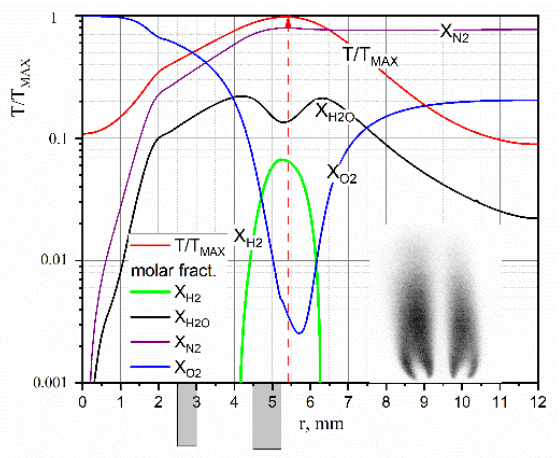
Figure 4. Reconstructed temperature and composition values in H 2 /O 2 flame.